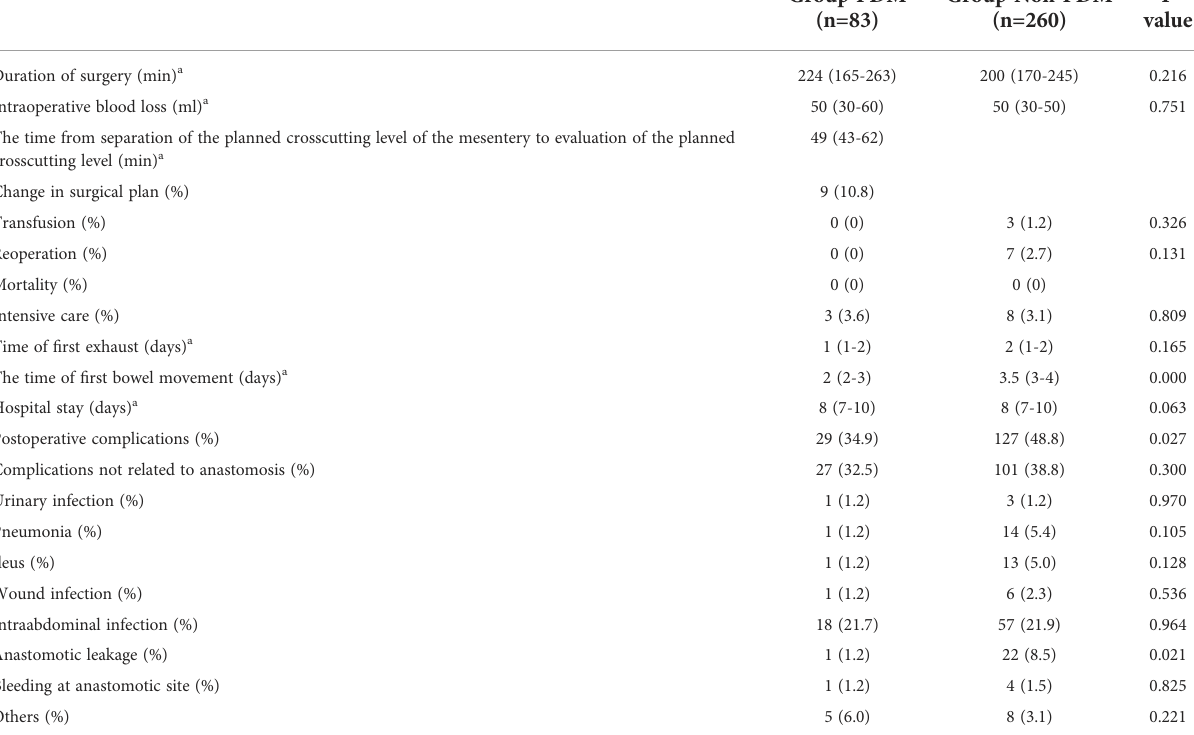
TABLE 2 Operative outcomes and postoperative complication before propensity score matching.